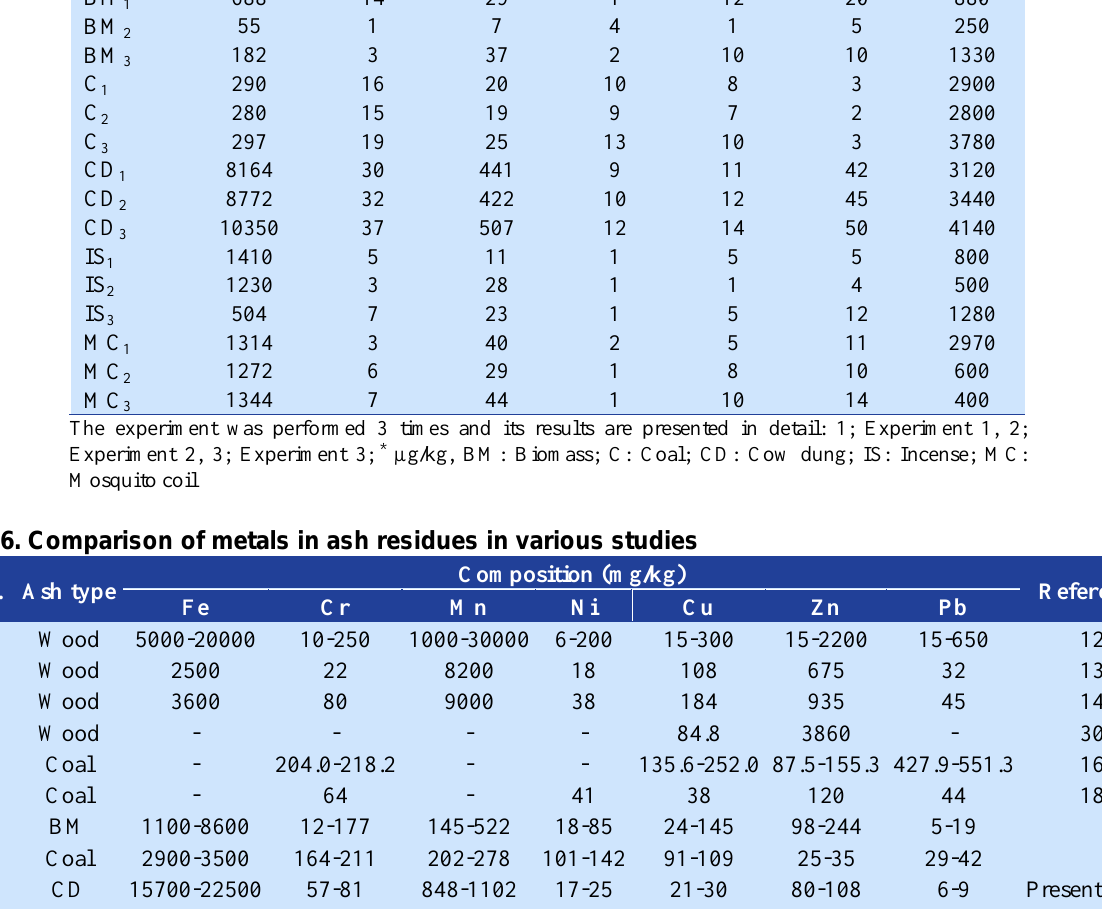
Table 5. Fluxes of metals in indoor ash residues (mg/kg) Samples